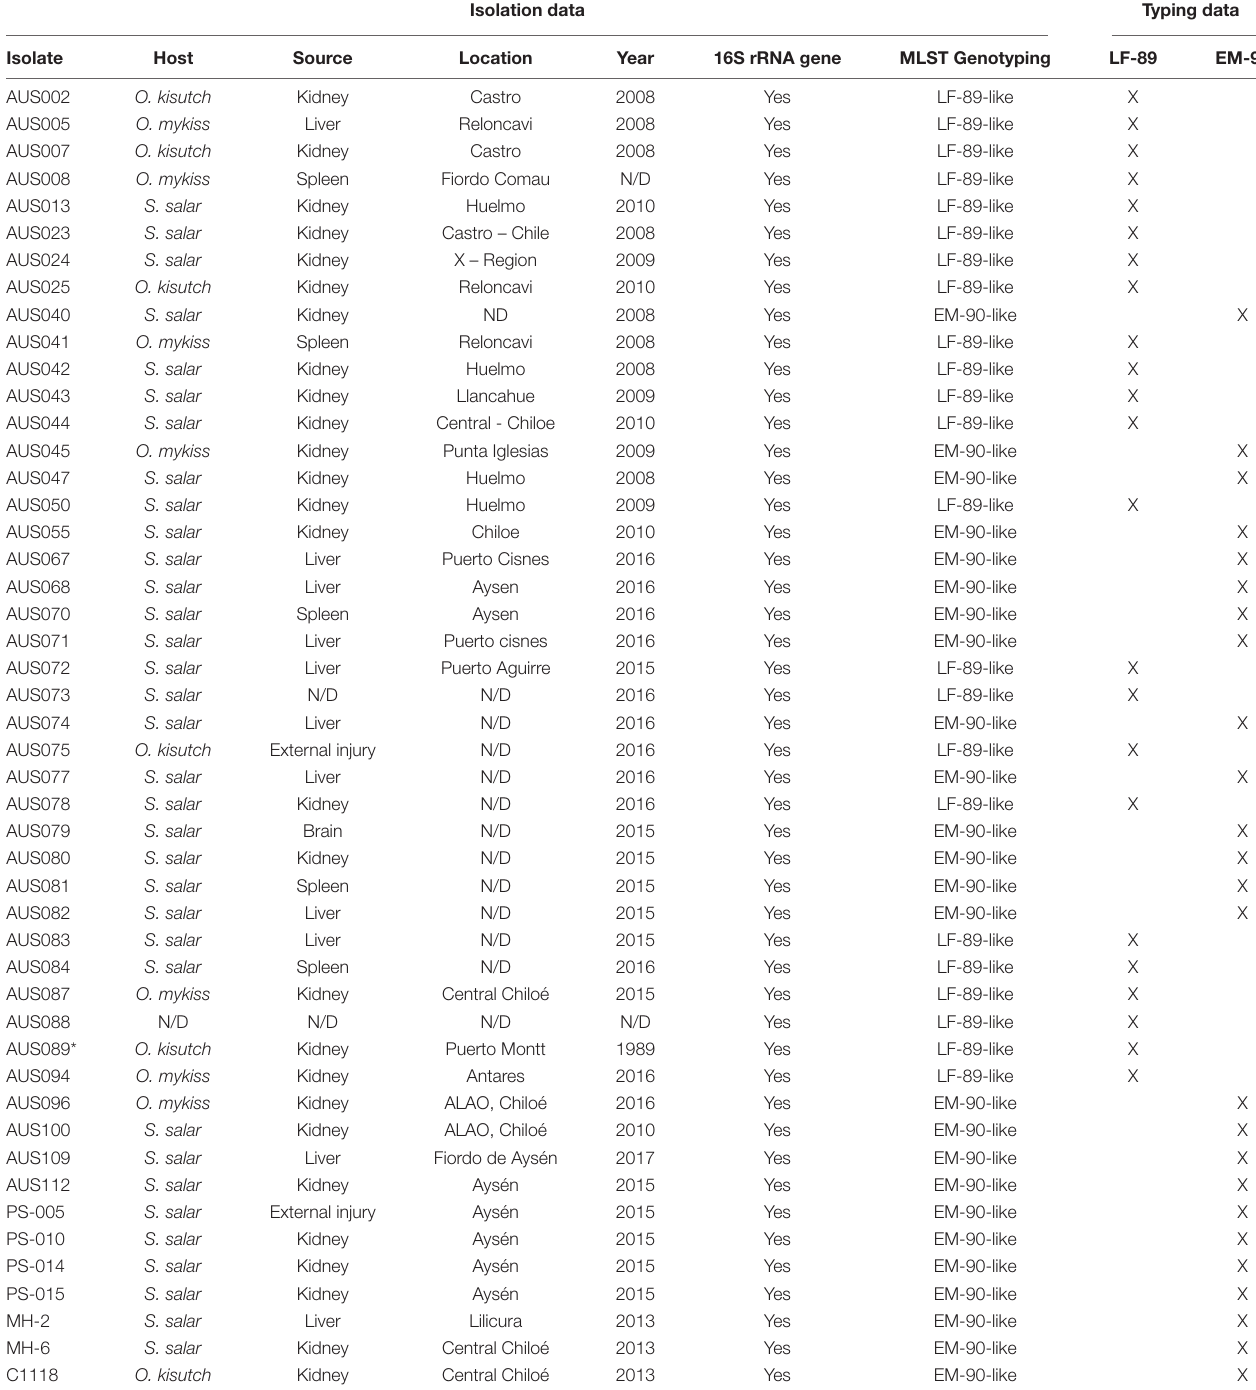
TABLE 2 | Genotyping results using multiplex PCR for 48 P. salmonis isolates obtained from different hosts ( Salmo salar, Oncorhynchus mykiss, and Oncorhynchus kisutch ), sources, years, and locations in Chile. Isolation